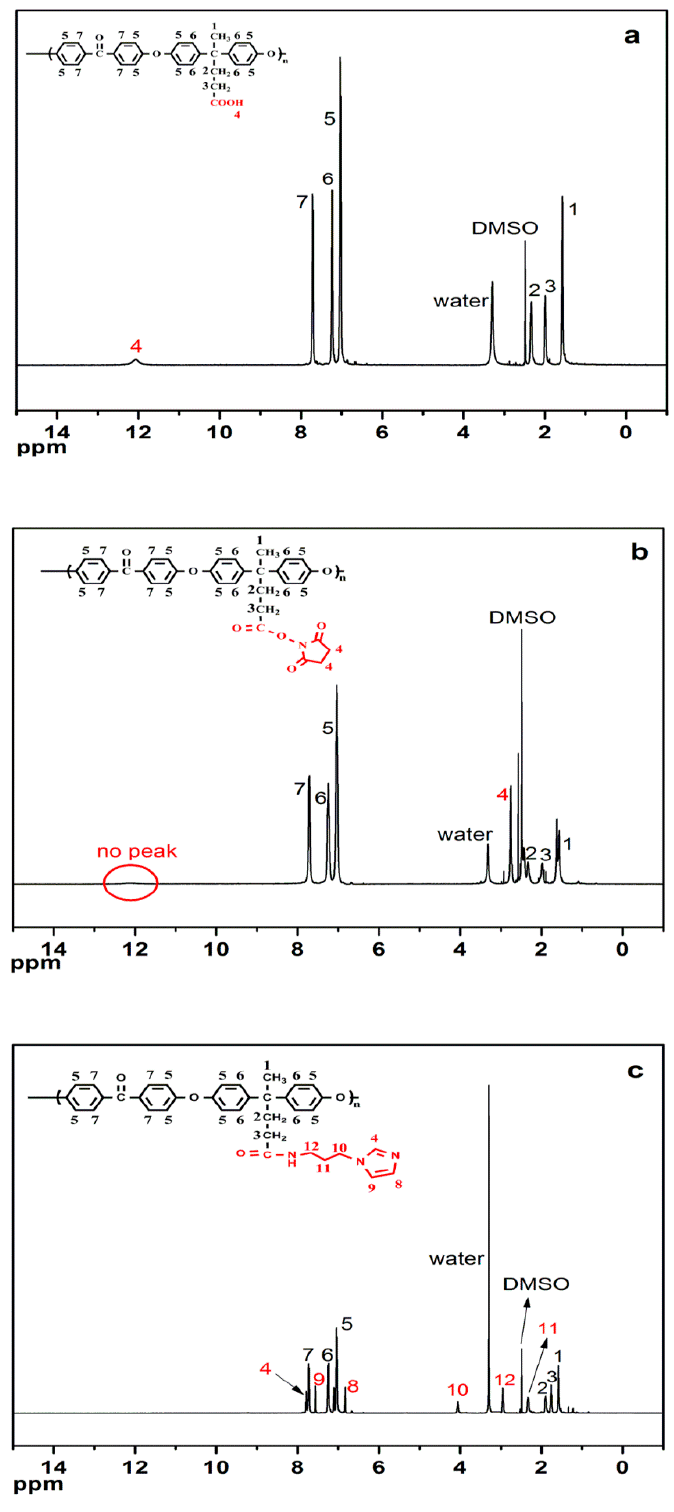
Figure 1. 1 H NMR spectra of ( a ) PAEK-COOH and ( b ) PAEK-NHS ( c ) PAEK-API precursors. The QPECH/PAEK-API cross-linked membrane was totally different in physical appearance from the QPECH and PAEK-API blend membrane, simply obtained by mixing PAEK-API and QPECH solutions. In Figure 2a and Figure 2b, while the blend membrane is opaque, the cross-linked